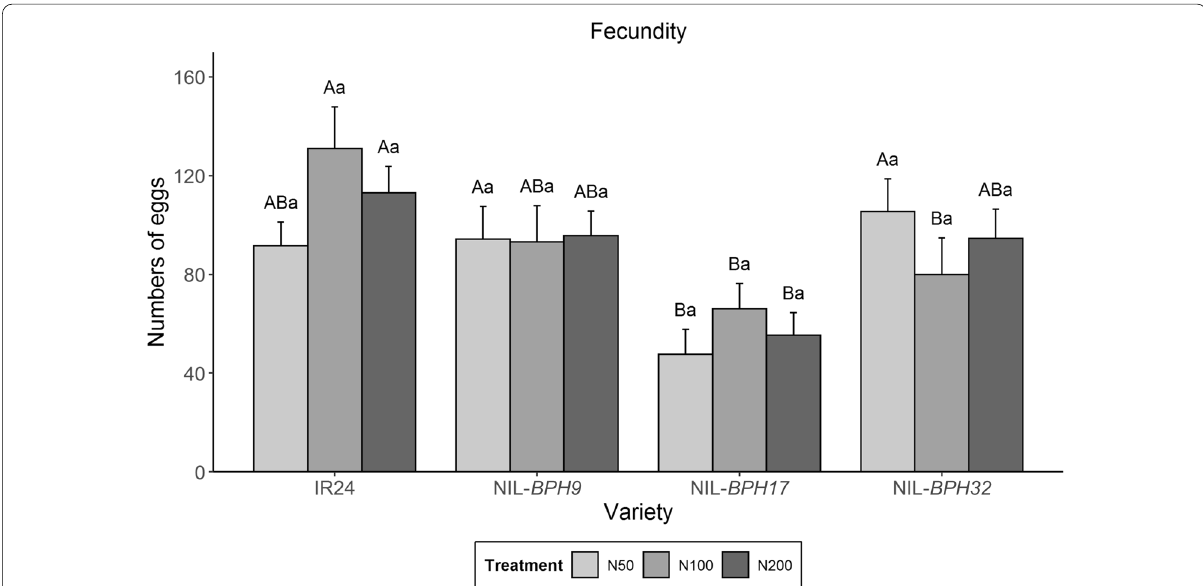
Fig. 5 N. lugens female fecundity on IR24, NIL‑ BPH9 , NIL‑ BPH17 , and NIL‑ BPH32 under different nitrogen regimes. Means in each column followed by the same capital letter do not differ significantly among varieties ( p < 0.05). Means in each column followed by the same lowercase letter do not differ significantly among different nitrogen treatments. The error bars indicate the S.Es